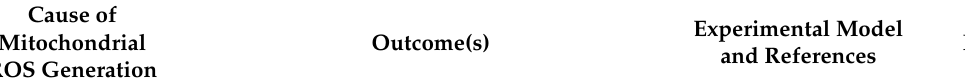
Table 2. Defective mitochondria are a major cause of mitochondrial ROS